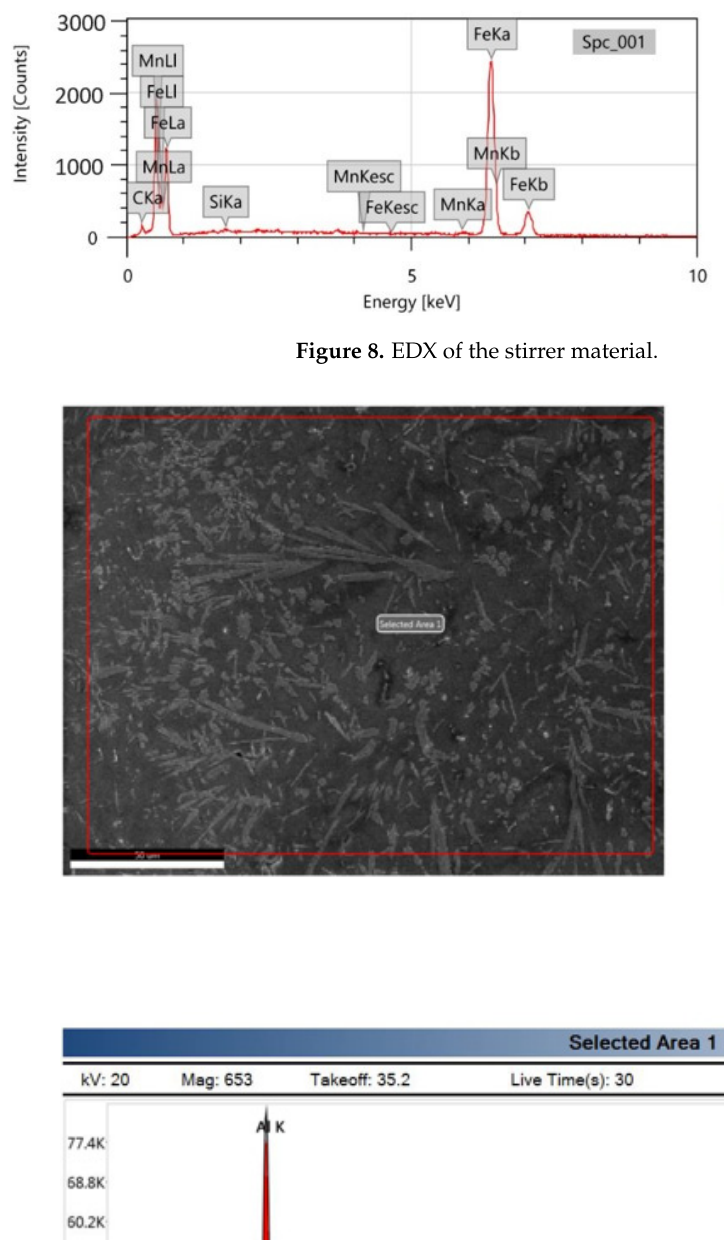
8 of 14 Figure 6. ( A ) Microstructure of Al6061 stirred for 15 min; ( B ) microstructure of Al6061 stirred for 20 min.